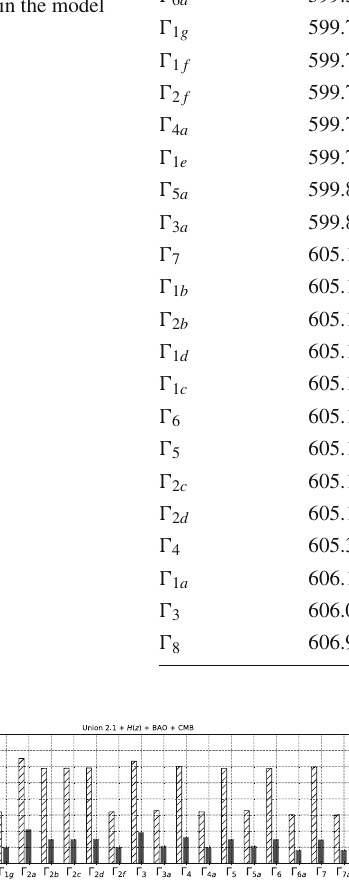
according to BIC. In the left panel we show the joint analysis of Union 2.1 + H ( z ) + BAO + CMB and in the right panel we have the joint analysis of binned